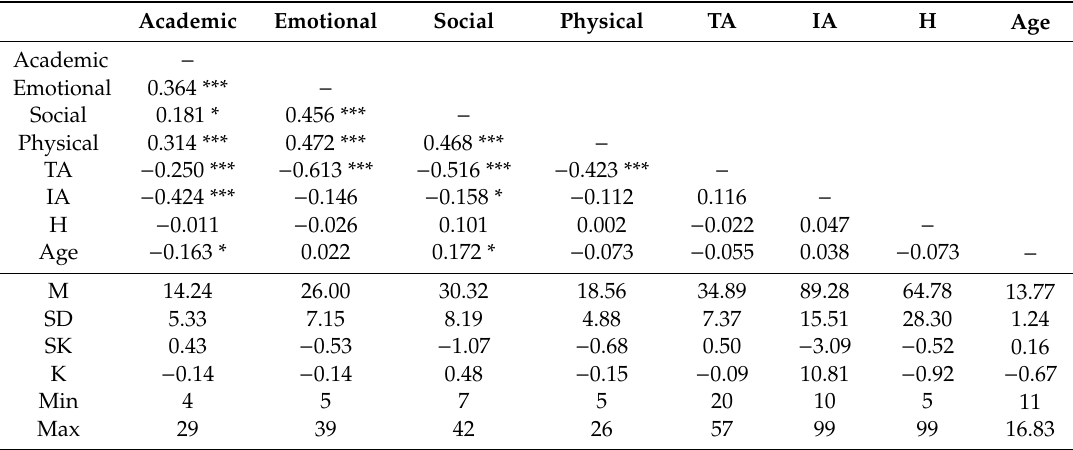
Table 1. Descriptive statistics and Pearson correlation